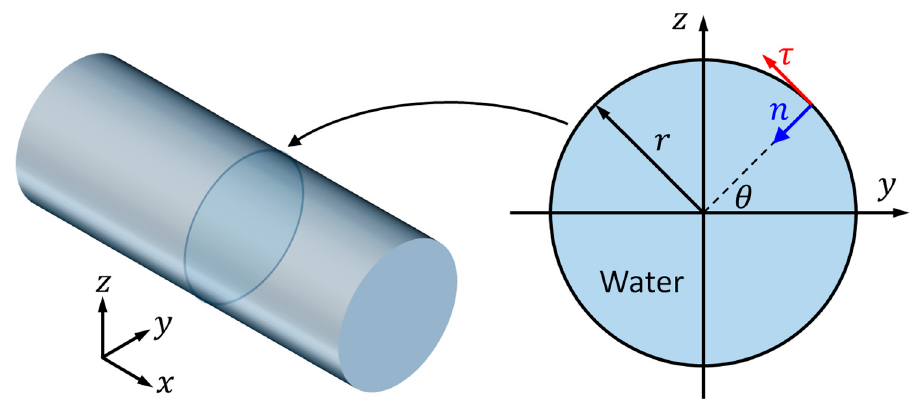
Figure 1. A two-dimensional reduced-fluid model ( right ), which takes a cross-section of a cylindrical cavity ( left ), was considered. r is the radius of the cross-section of the channel; θ is the angle of a point on the boundary; and, τ and n represent the tangential and inward normal directions of the point on the boundary, respectively.